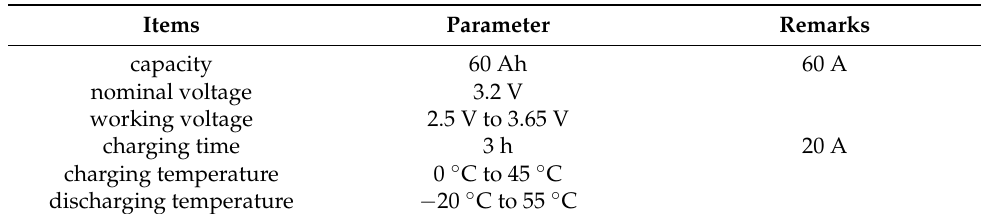
Figure 3. Experimental environment. ( a ) The lithium iron phosphate echelon-use battery (60 AH, 3.2 V). ( b ) The charge/discharge experiment. Table 1. Parameters of the echelon-use